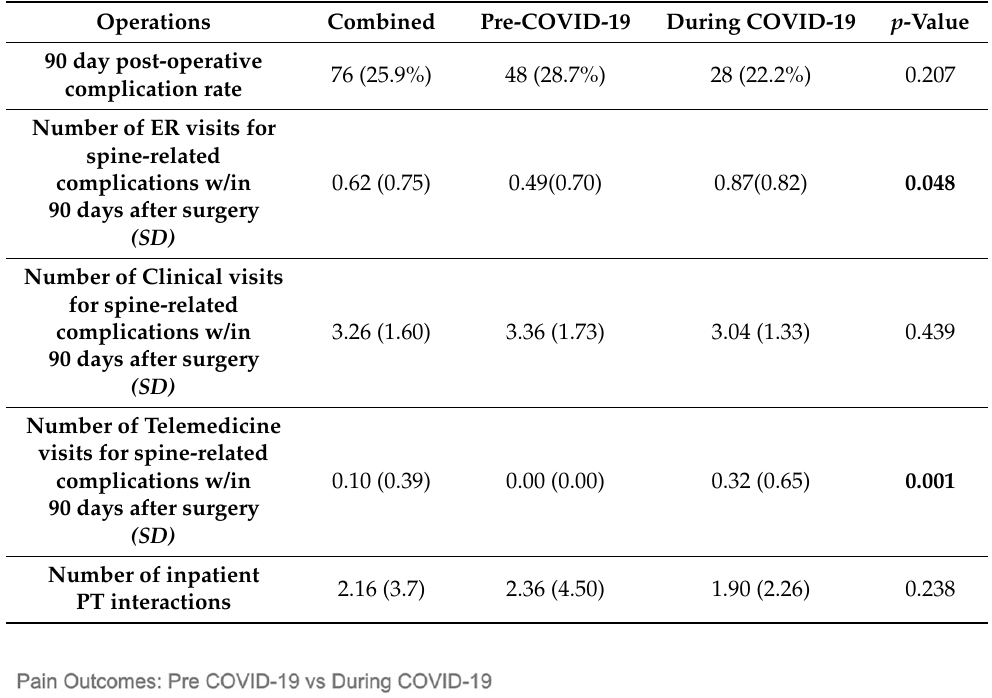
Table 4. Comparison of Complications and Different Types of Visits Post Surgery between Pre- and During COVID-19. Significant p -values are indicated in bold.